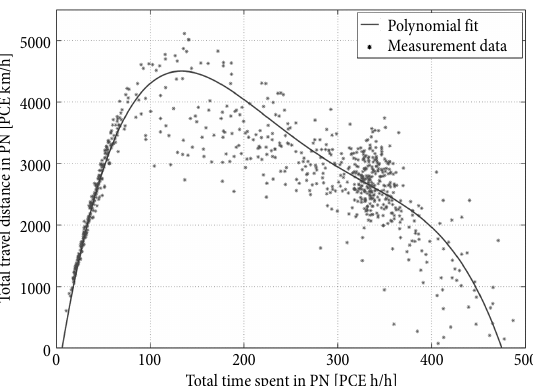
Fig. 2. NFD Fundamental diagram of the PN